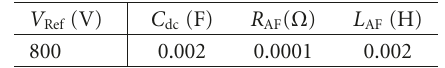
Table A.8: Parameters of an active filter of test system 2.